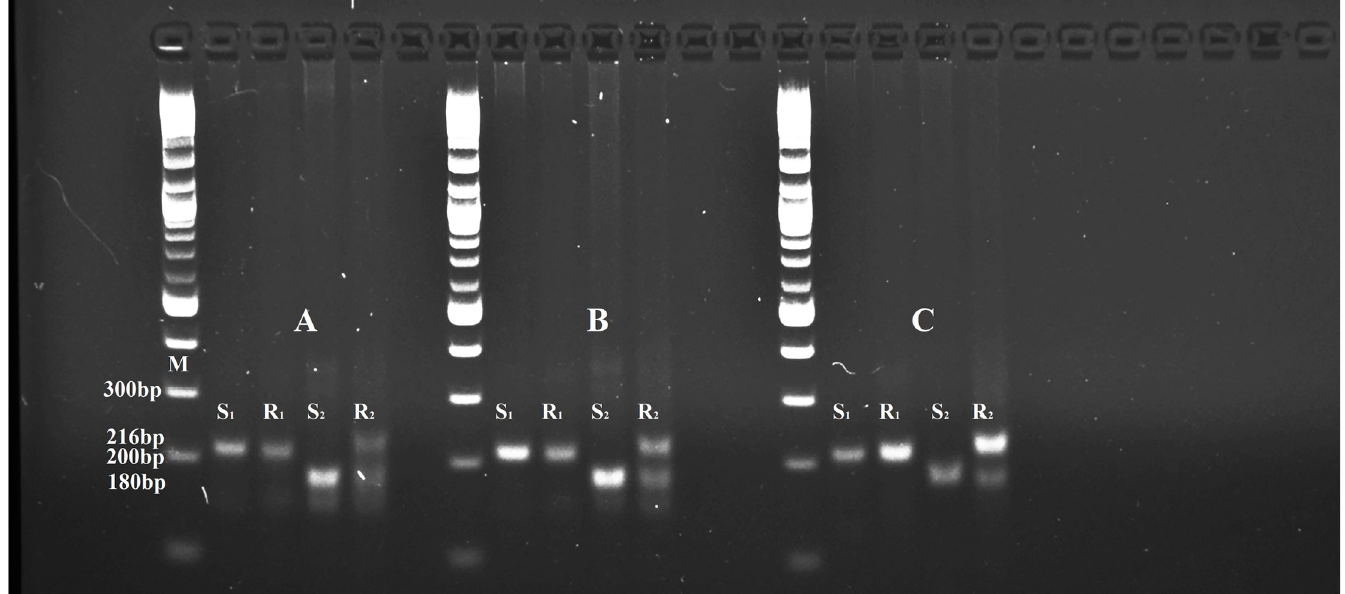
Fig 1. Digestion patterns of three restriction enzymes, Msc I (A), Sau 96I (B) and Nla IV (C) used for the dCAPS markers for detecting mutations at position Pro-106 in EPSPS gene in glyphosate-resistant population O (R) and glyphosate-susceptible population SP (S). S 1 and R 1 represent undigested samples showing the 216 bp dCAPS amplicon from an individual each of population S and O, respectively. S 2 represents restriction enzyme-digested samples for the glyphosate susceptible individual yielding a single ~180 bp fragment. This individual was homozygous for the wild-type glyphosate sensitive allele of the EPSPS gene that harbors the C nucleotide at the codon 106 required for restriction enzyme cleavage in these dCAPS assays. The glyphosate-resistant individual (R 2 ) had a 216 bp and ~180 bp fragment showing the presence of a mutation at codon 106 of the EPSPS gene for one allele as well as the wild-type sensitive allele, indicating this plant was heterozygous for these alleles. M denotes the DNA size standard lanes showing the 200 and 300 bp fragments of the 1 kb Plus size marker ladder (NEB, UK). The samples were resolved and visualized by electrophoresis in an agarose lithium borate buffer (2% w v -1 ) gel containing 0.5 μ g ml -1 ethidium bromide.